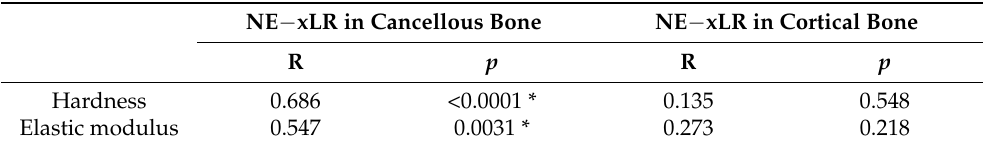
Table 2. Pearson correlation coefficient between NE − xLR and bone micromechanical properties (* p <